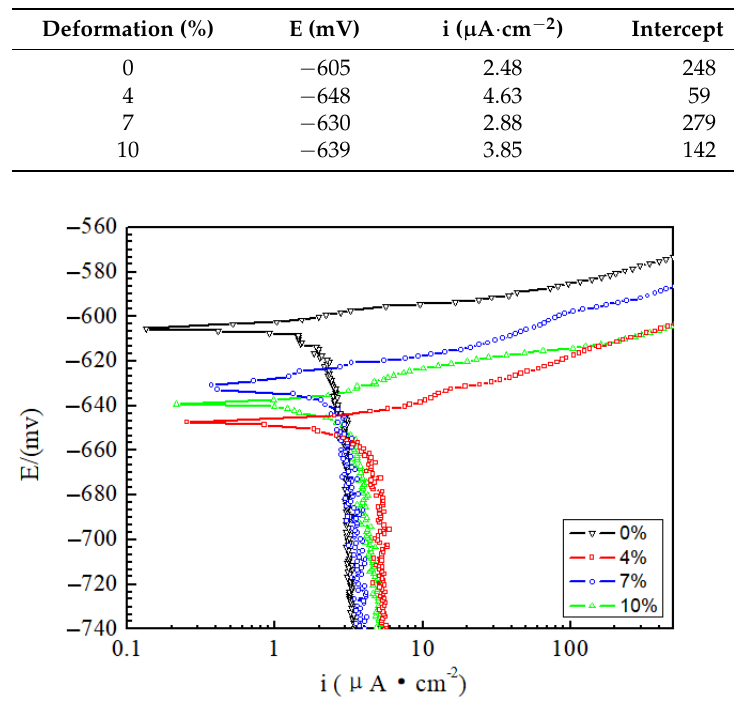
Figure 3. Tafel polarization curves of the 2024 FSWed joints with different deformations (0%, 4%, 7%, and 10%) in the 3.5% NaCl electrolyte. Table 2. Data extracted from the Tafel polarization curves in Figure 3.